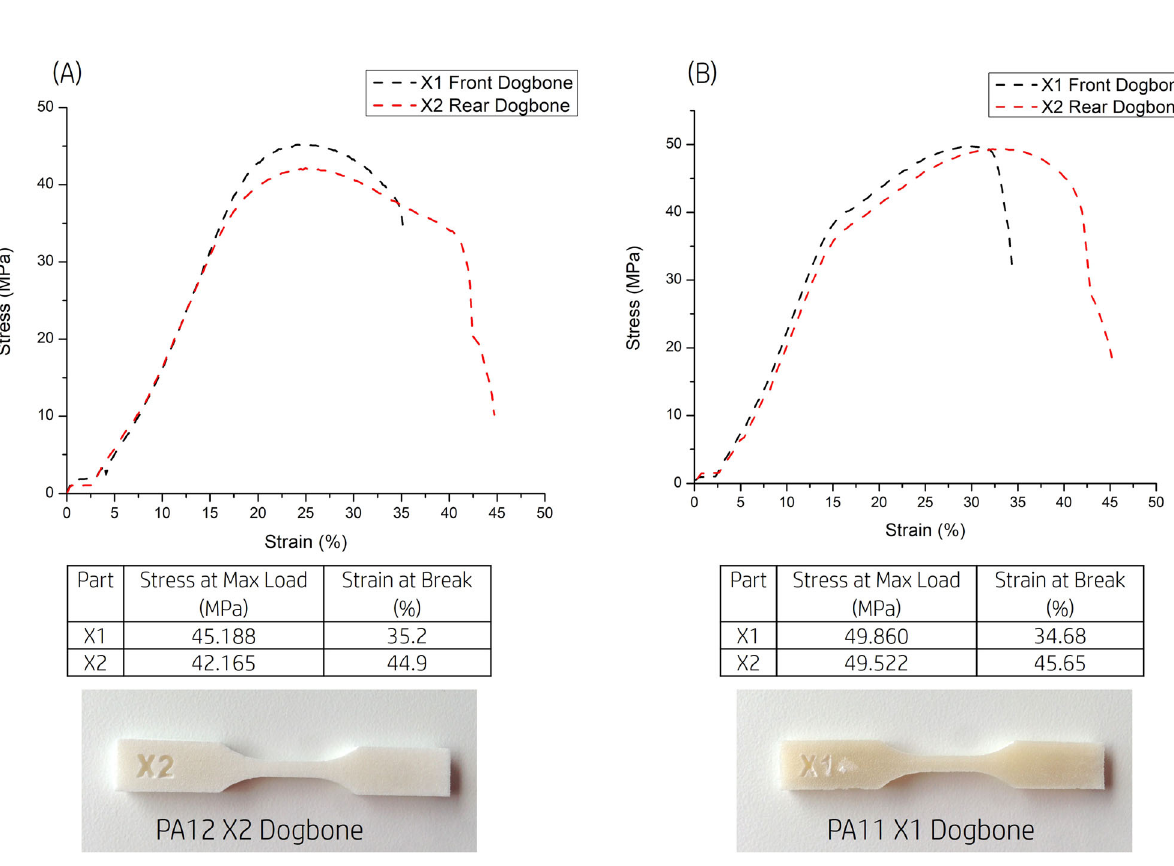
Fig.9 |MechanicalpropertiesofPA12dogboneprintedwithAFA.A Stress – straincurveofPA12 XY -orientatedASTMD368dogboneandcorrespondingX2dogbone. B Stress – strain curve of PA11 XY orientated ASTM D368 dog bone and corresponding X1 dog bone. Stress – strain curves of PA12 and PA11 printed with AFA.